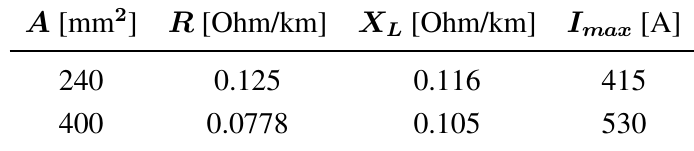
Table 3. Features of the proposed lines for the studied grid.